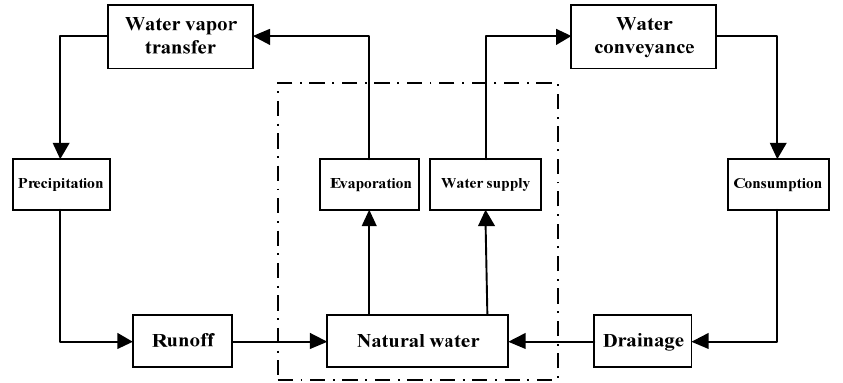
Figure 3. Schematic diagram of the dualistic water circulation system.